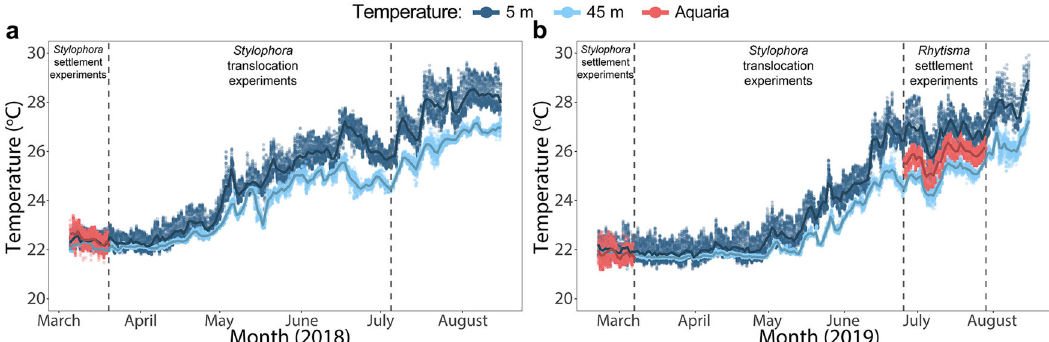
Fig. 5 Temperature regime during the study period. Temperatures in the experimental aquaria and in the open sea at depths of 5 and 45 m during ( a ) 2018 and ( b ) 2019. Points represent continuous measurements taken every 15 min and lines represent the daily temperature